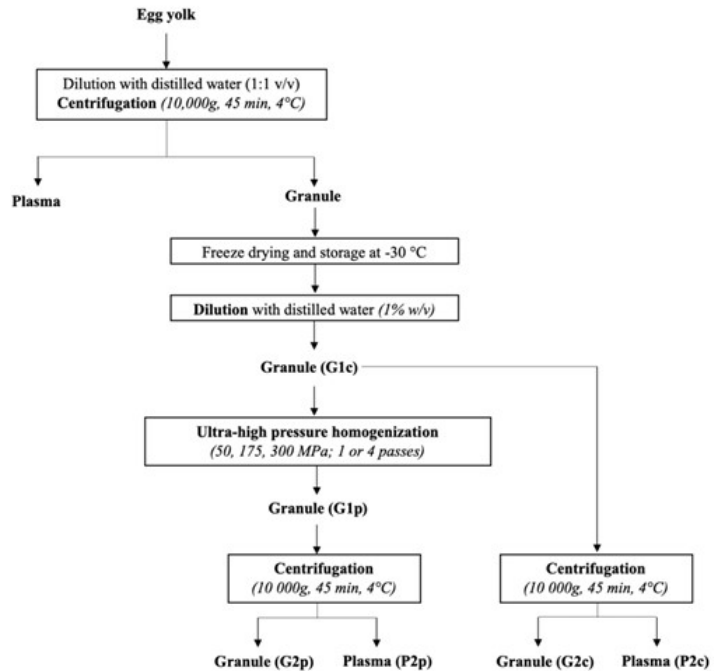
Figure 1. Experimental design of the production of the different fractions from egg yolk granule after ultra-high-pressure homogenization treatments. G1c: initial control granule, G1p: initial pressure-treated granule, G2p: granule from initial pressure-treated granule, P2p: plasma from initial pressure-treated granule, G2c: control granule from initial control granule, P2c: control plasma from initial control granule.